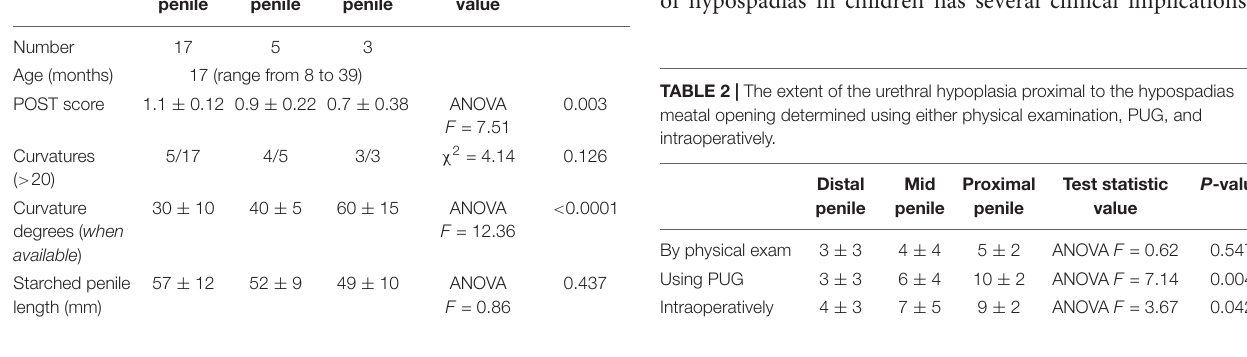
is similarly covered by the tunica albuginea. Buck’s fascia is superficial to the tunica albuginea and overlies all of the structures described above ( Figure 2 ).